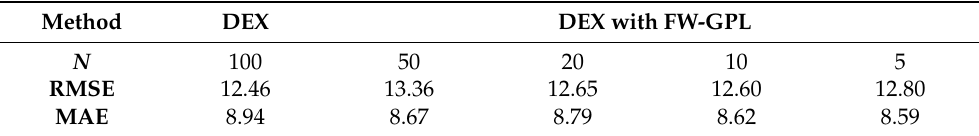
Table 6. Test performance of the FW-GPL method, with the L Win = 10 (set length of output neurons N as [100, 50, 20, 10, 5]).